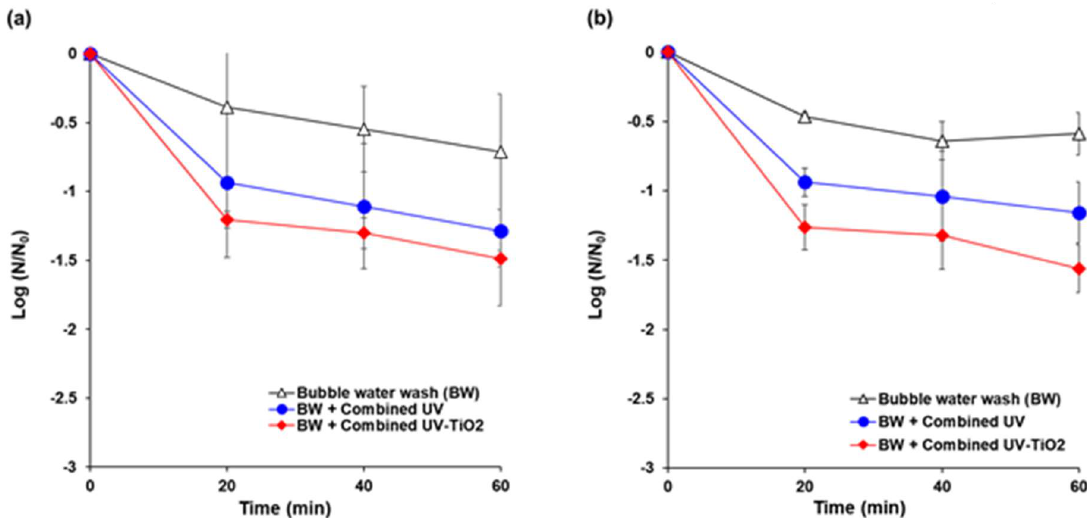
Figure 7. Inactivation of microbial contamination on fresh cut carrots using combined UV and combined UV-TiO 2 . ( a ) E. coli K12; ( b ) Saccharomyces cerevisiae . Bubble water wash (BW) = air bubbling as a control; Combined UV = UVC and VUV; combined UV-TiO 2 = UVC-assisted TiO 2 photocatalytic; and, VUV-assisted TiO 2 photocatalytic treatment. The N 0 of E. coli K12 and S. cerevisiae were in the range of 6.5–8.0 log CFU / cm 2 and 4.3–5.6 log CFU / cm 2 , respectively. The results represent the mean of three measurements ± standard deviation.